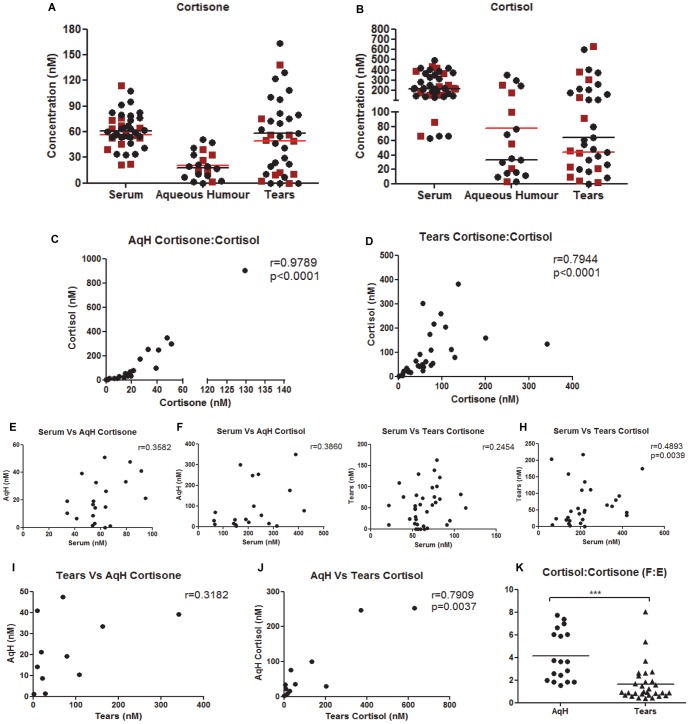
Hormones detected in human ocular biofluids versus serum.A) Cortisone and (B) cortisol levels in the tear film and AqH. There was no gender dependency for any of the analyte (• black circle, Male and (▪ red square, Female)). There was a positive correlation between cortisol and cortisone in both ocular biofluids (C–D), but concentrations were largely independent of those found in serum (E–H). There was an association between AqH and Tear film cortisone (I) and cortisol (J), and cortisol∶cortisone (F∶E) ratios were consistently higher in AqH versus the tear film (K).